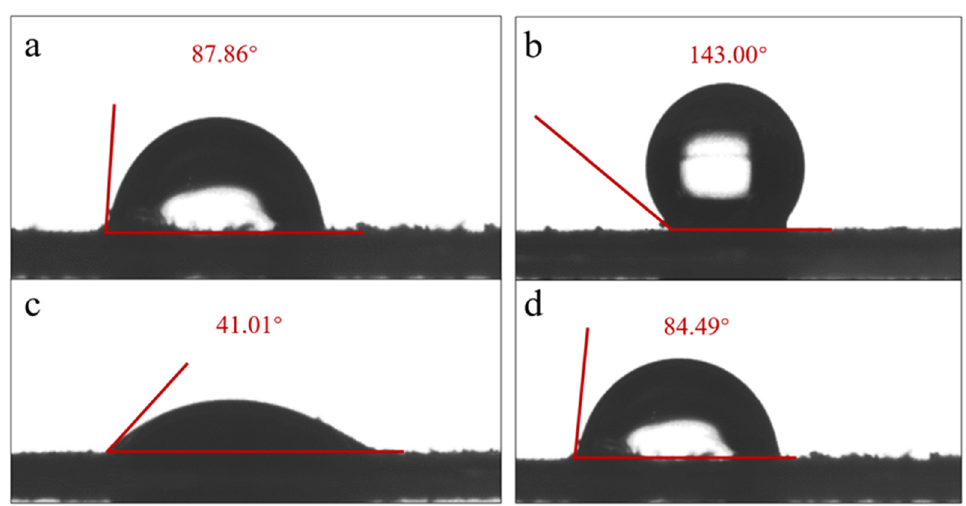
Figure 6. Contact angle results of MPs before and after UV aging (( a ) P-PBAT, ( b ) P-PS, ( c ) A-PBAT, and ( d ) A-PS). and ( d )